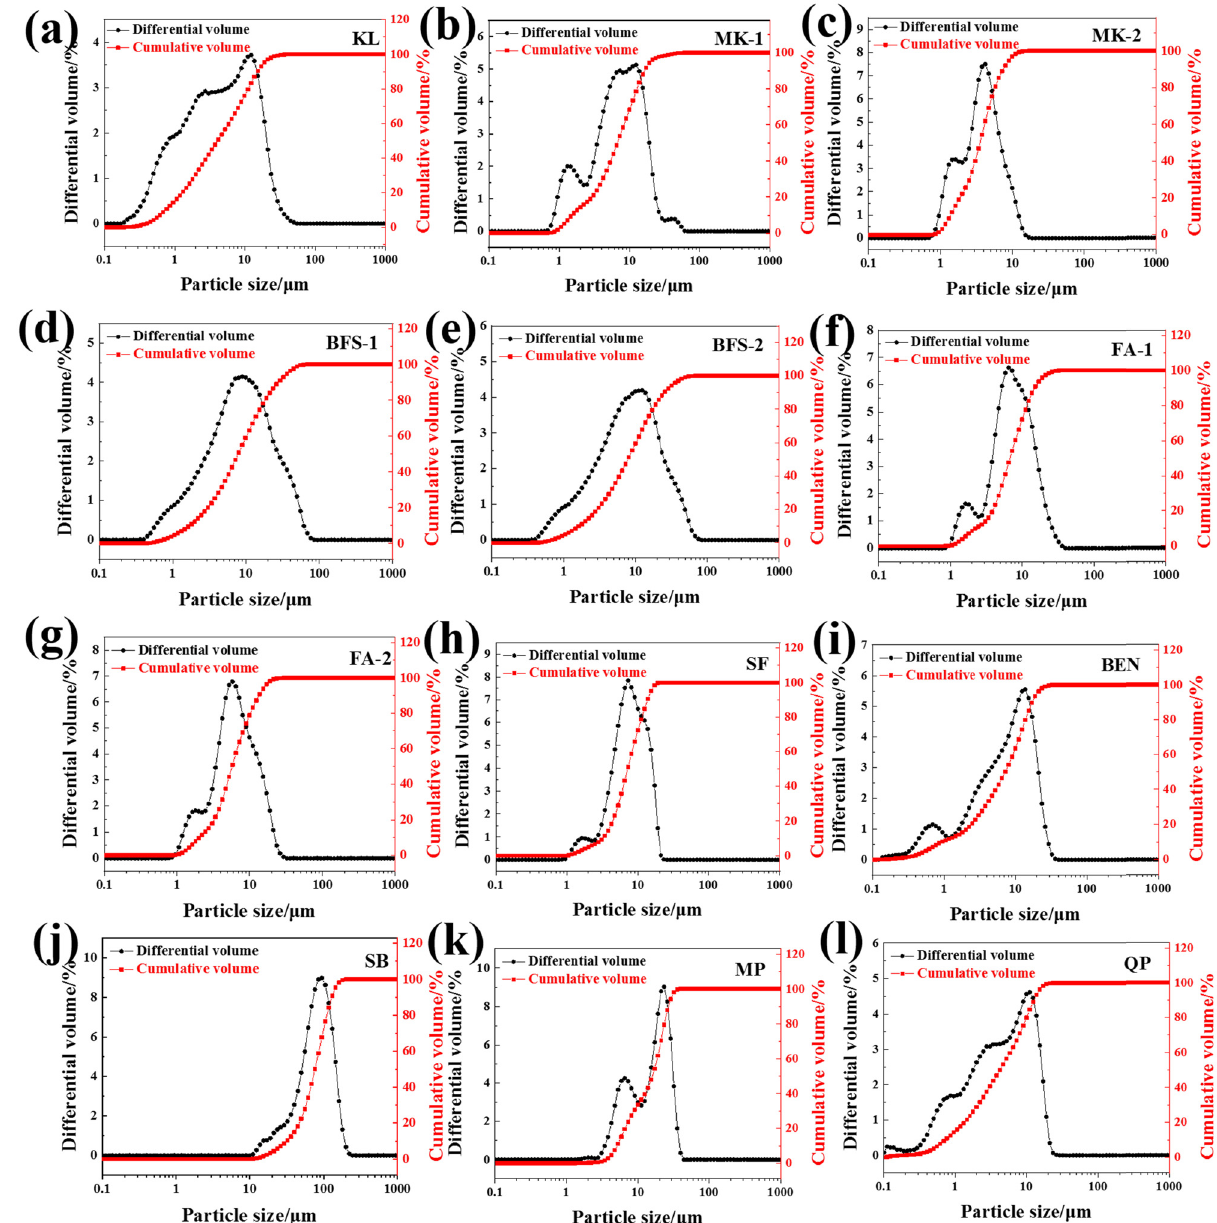
Figure 2: The particle size distribution of raw materials: ( a ) KL; ( b ) MK - 1; ( c ) MK - 2; ( d ) BFS - 1; ( e ) BFS - 2; ( f ) FA - 1; ( g ) FA - 2; ( h ) SF; ( i ) BEN; ( j ) SB; ( k ) MP; ( l )